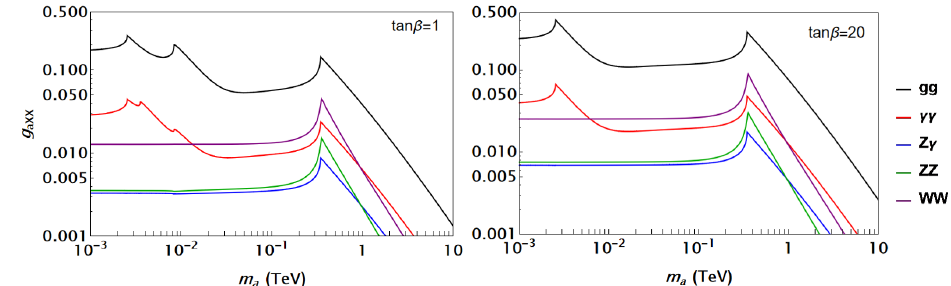
Figure 3 . Predicted ALP couplings to gauge bosons with x = 1 on the left and x = 20 on the right. The different peaks correspond to kinematic thresholds, namely m a = 2 m f for different fermions, which are almost lost in the presence of EW gauge bosons due to their high